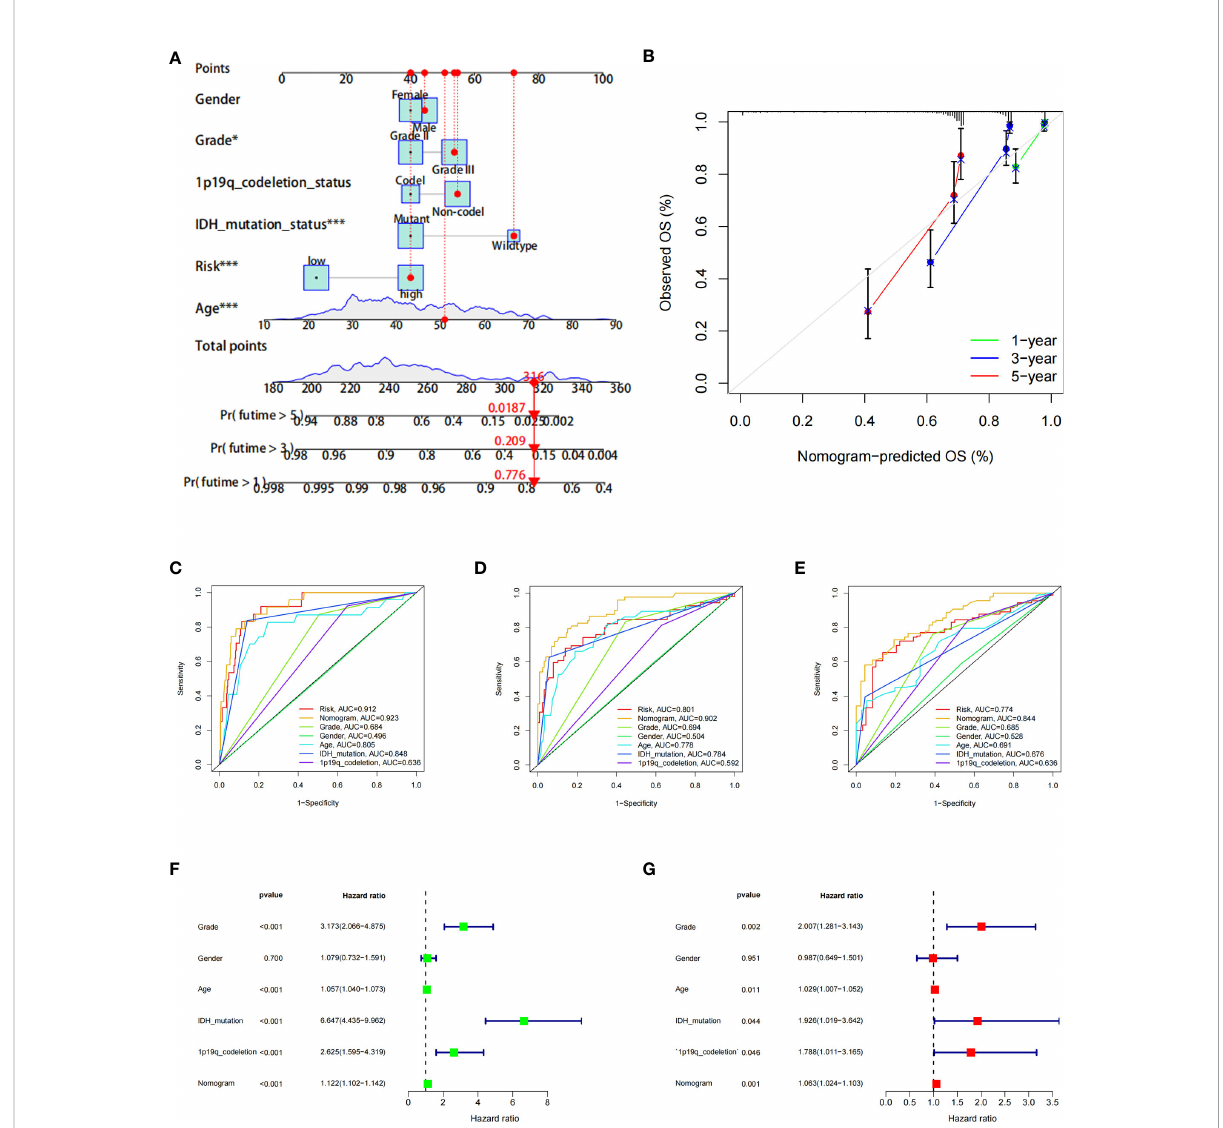
FIGURE 6 The prognostic value of the risk score combined with clinicopathological features in the OS of patients from the TCGA database. (A) Nomogram shows OS in TCGA database of patients. (B) The nomogram ’ s calibration plots. The y-axis represents actual survival, whereas the x-axis represents nomogram-predicted survival. (C – E) ROC curve of risk scores and clinicopathological factors for predicting 1- (C) , 3- (D) , and 5-year (E) OS. (F, G) Nomogram results based on univariate and multivariate Cox regression